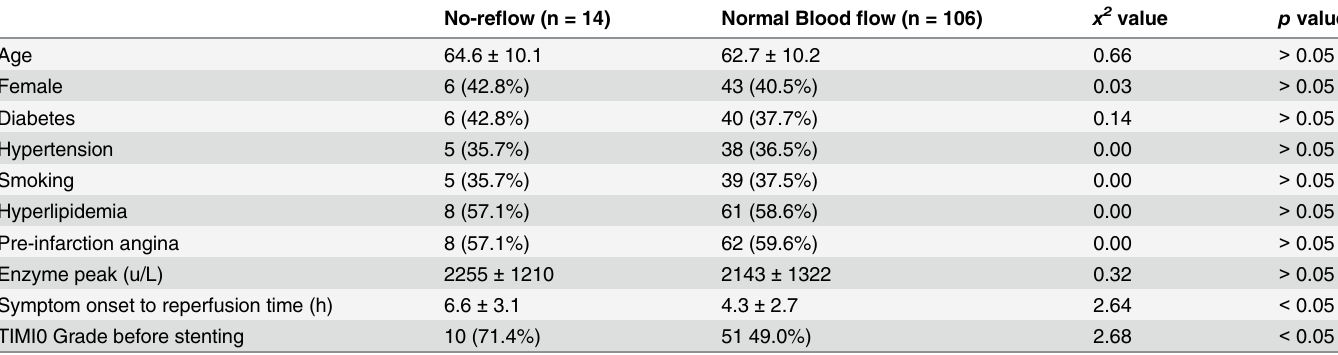
Table 1. Comparison of clinical data and coronary lesions between the 2